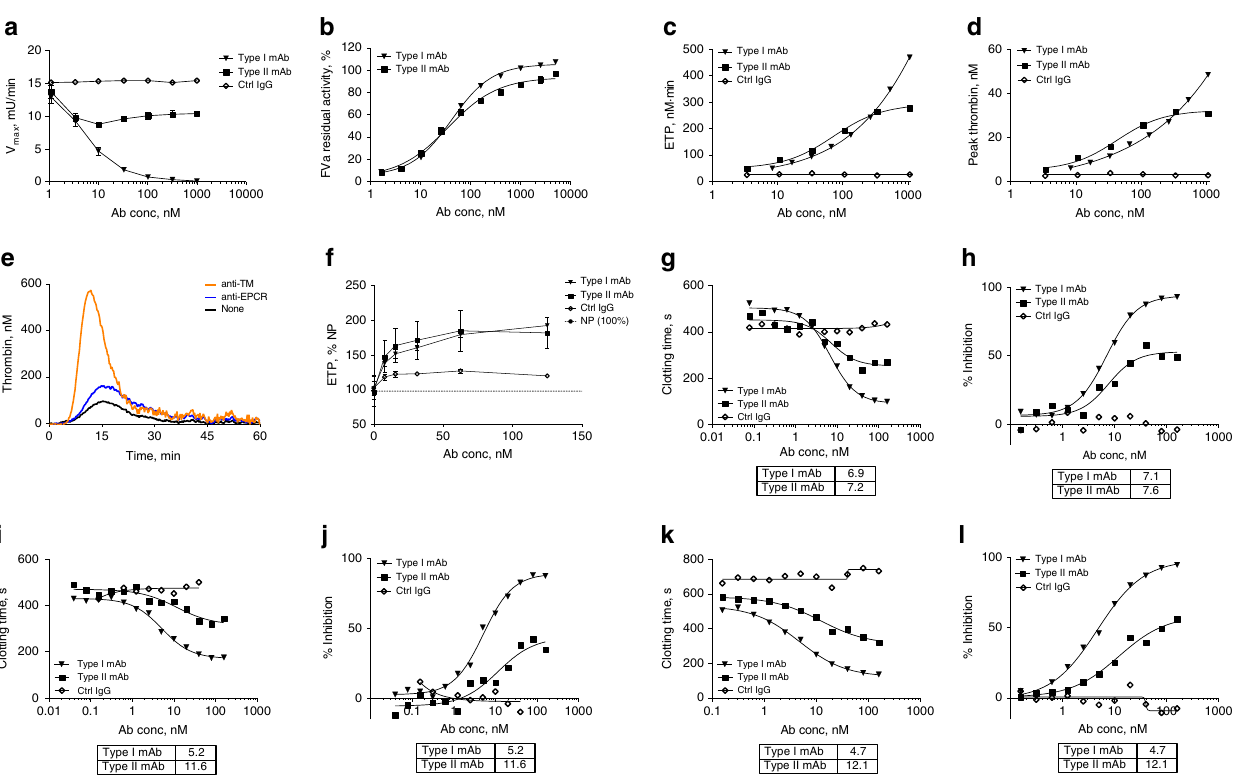
Fig. 3 Type I and type II mAbs are procoagulants in vitro. a APC amidolytic activity is de fi ned by the maximum velocity ( V max ) of its hydrolyzing reaction toward the small chromogenic substrate spectrozyme PCa, and percent inhibition of APC amidolytic activity by mAbs is shown in Supplementary Fig. 3. Data are expressed as mean ± SD. N = 4 – 6. b Both mAbs protect FVa from APC-mediated proteolysis. In the absence of APC, the activity of FVa in the prothrombinase assay was designated as 100%. In the absence of added antibodies, APC proteolyzed FVa and reduced its activity to 6.4 ± 0.3% (mean ± SD). Assays were repeatedly performed in triplicates; a typical curve is shown. c , d TM – TGA in normal human plasma (FACT): c ETP and d peak thrombin levels. e , f TGA on EA.hy926 endothelial cells: e baseline thrombin levels (nM) shown as a representative experiment and f ETP as %NP (percent of normal pooled plasma). Data represent mean values ± SD from three independent experiments. g – l Plasma-clotting assays where IC 50 values in nM of mAbs are compared in a table below each panel. Protac-aPTT using FACT: g clotting time in seconds (s), h percent inhibition. Protac-aPTT using HemA plasma: i clotting time in seconds (s) and j percent inhibition. Protac-aPTT using FVIII Ab-treated FACT: k clotting time in seconds (s) and l percent inhibition. In c – l , experiments were run with replicate samples in each assay, and data re fl ect the average of two replicates. Assays were repeated ≥ 3 times. FACT normal human plasma, Protac a protein C activator from A. contortrix